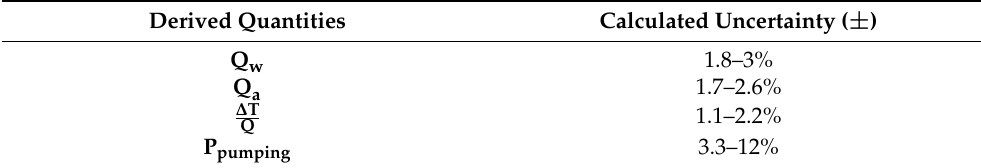
Table 3. Calculated uncertainties for key pressure-drop and heat transfer parameters. Derived